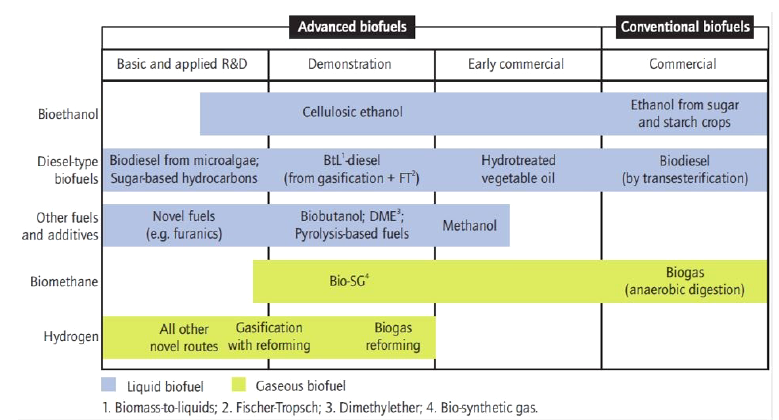
Fig. 3. – Maturity of biofuel technology